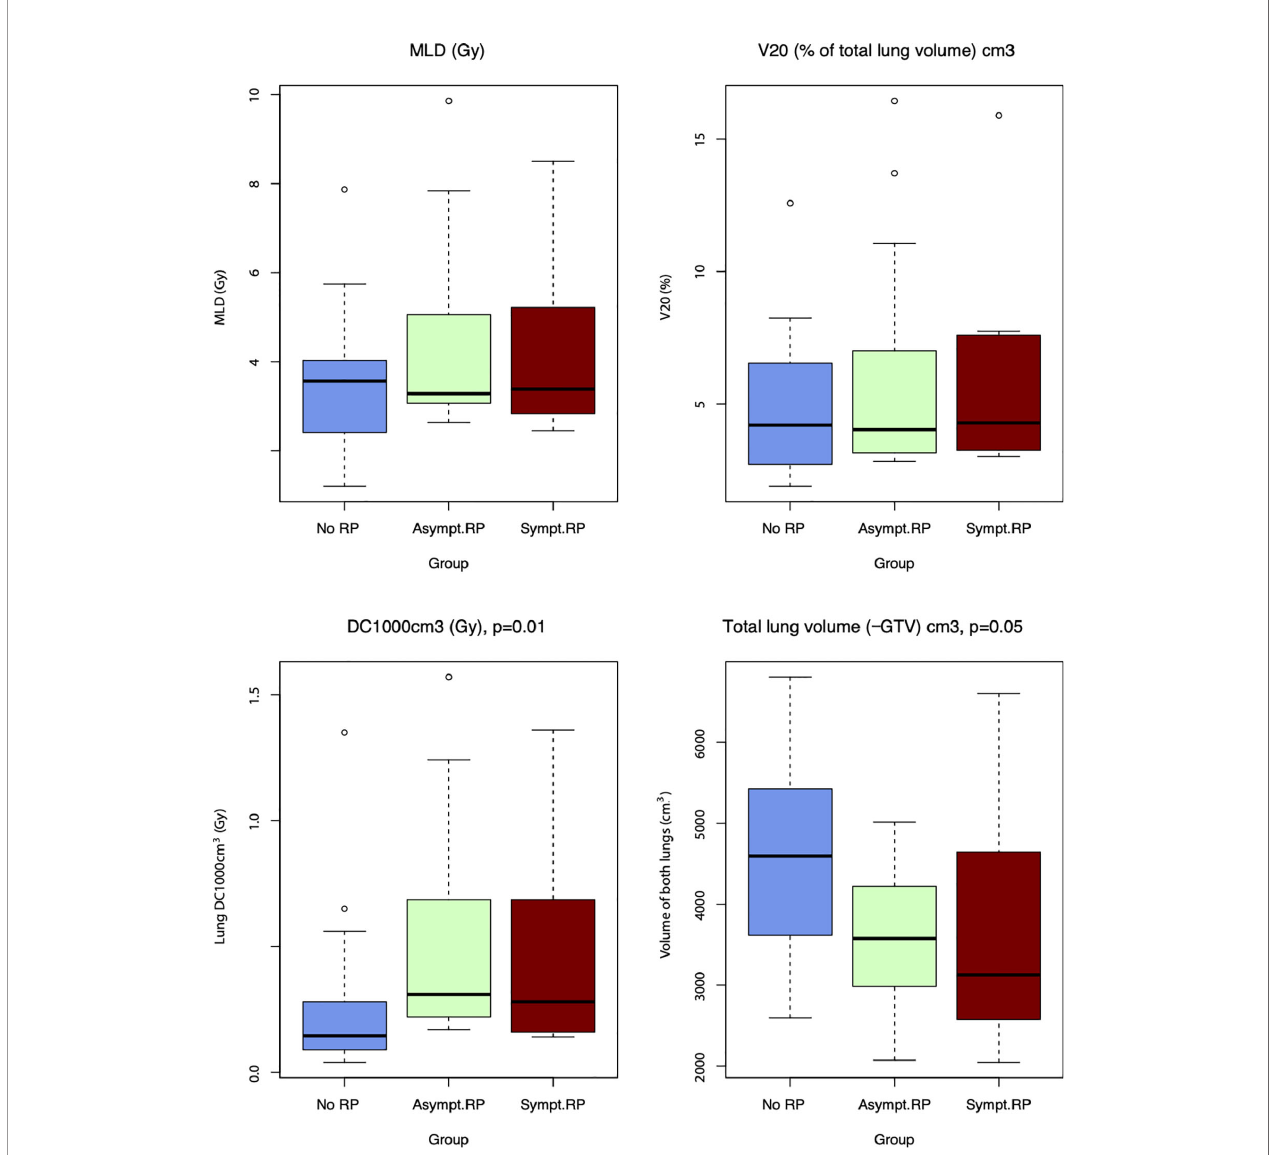
FIGURE 5 | Correlation between MLD, V20, DC1000 cm3, Total lung volume cm 3 and lung toxicity.